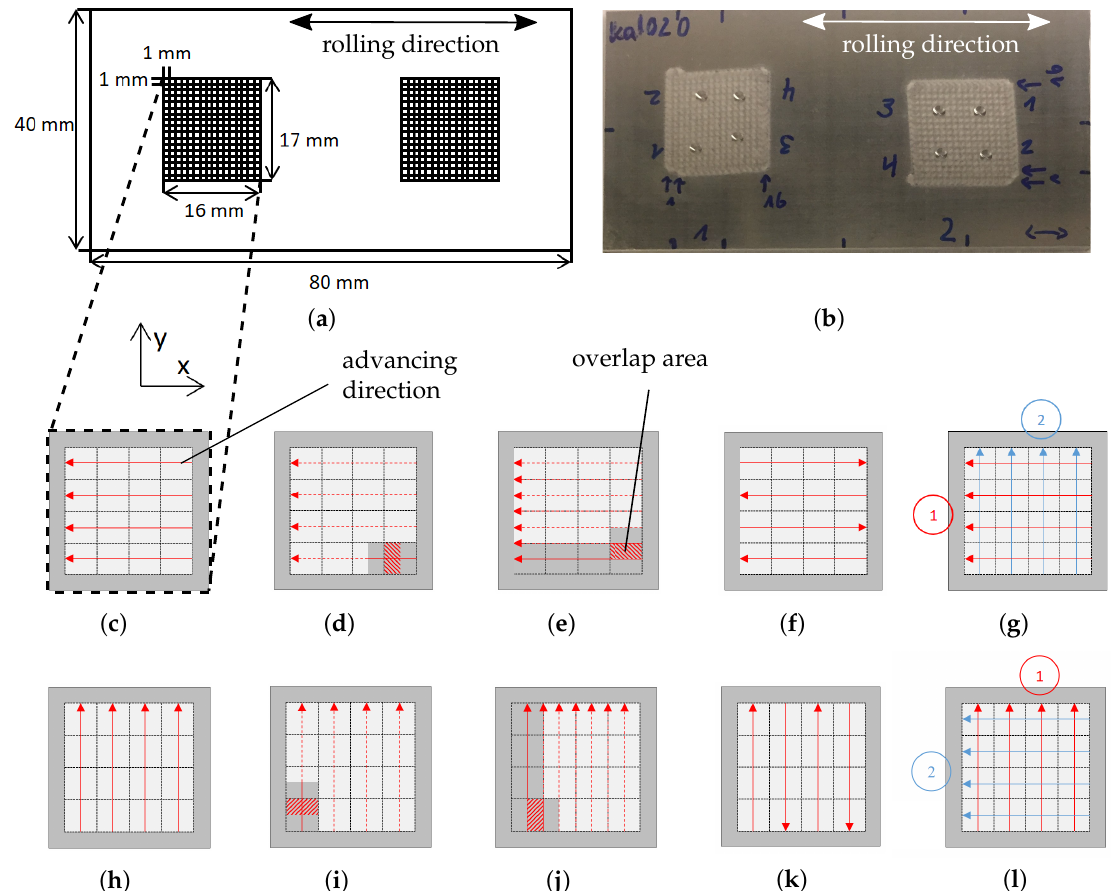
Figure 1. ( a ) An illustration of the specimen dimensions with a schematic peening area; ( b ) a peened specimen after residual stress measurements; ( c – l ) the schematic shot patterns used in this study: ( c – f ) one peening sequence with an advancing direction parallel to the rolling direction: ( c ); ( d ) overlap in the advancing direction; ( e ) overlap orthogonal to the advancing direction; ( f ) a row-wise change in direction; ( g ) the application of two orthogonal shot patterns, first parallel and second orthogonal to the rolling direction; ( h – k ) one peening sequence with an advancing direction orthogonal to the rolling direction: ( h ); ( i ) overlap in the advancing direction; ( j ) overlap orthogonal to the advancing direction; ( k ) a row-wise change in direction; ( l ) the application of two orthogonal shot pattern, first orthogonal and second parallel to the rolling